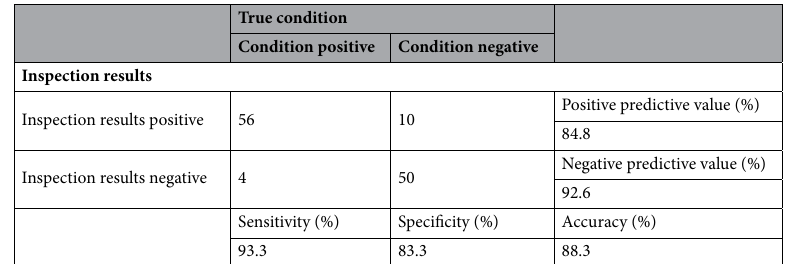
Table 2. The performance of the constructed model with the training